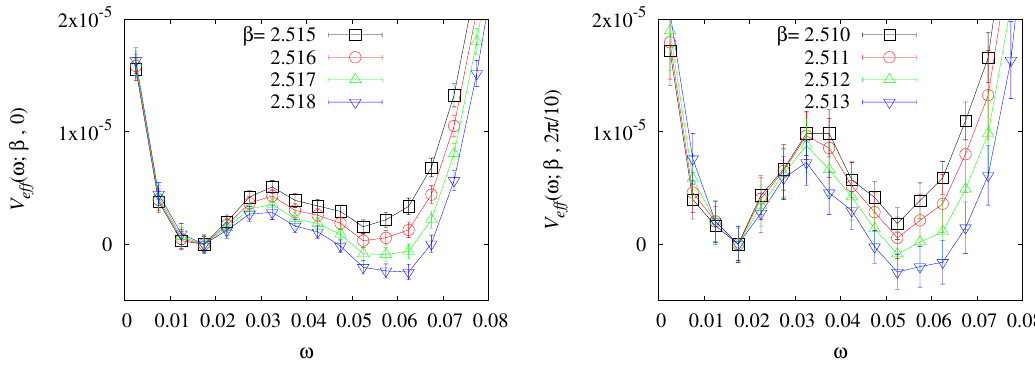
Figure 9 . V eff ( ω ; β, θ ) at θ = 0 (left) and 2 π/ 10 (right).